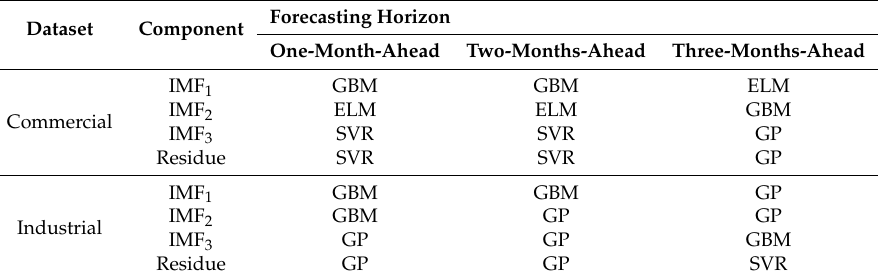
Table 3. Models adopted by each component in each dataset.